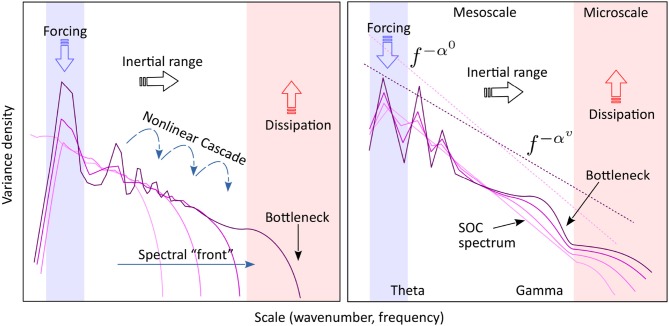
Left: The turbulence model. Energy is introduced into the system at the forcing scale (blue) is separated from the dissipation scale (red) by a “transparent” inertial range (white), largely free of forcing and dissipation. Non-linear interactions generate a cross-scale energy flux (cascade) from the source to the sink. Gray curves show the possible evolution of the spectrum toward stationary state, if initially the inertial range contains no energy. The stationary spectrum (purple) corresponds to a constant spectral flux of energy across the inertial range. A “bottleneck” in the spectral flux capacity at small scales may cause an accumulation of energy (spectral bump) at larger nearby scales. The axes are in logarithmic scale. Right: A schematic of the observed spectral evolution, interpreted in a way similar to turbulence. The light-colored spectrum is the background, corresponding to low activity (speed), and representing the self-organized critical (SOC) state. Increasingly dark lines represent the spectral shape at increasing intensity of activity (speed). The low-frequency peaks represent the theta rhythm and its harmonics (marked collectively as “theta”). A feature similar to the turbulent spectral front is observed in the gamma range. A spectral bump similar to a bottleneck (e.g., L'vov et al., 2007; Meyers and Meneveau, 2008; Proment et al., 2009; Nazarenko, 2011, see note in the text) is observed in the high-frequency gamma range.